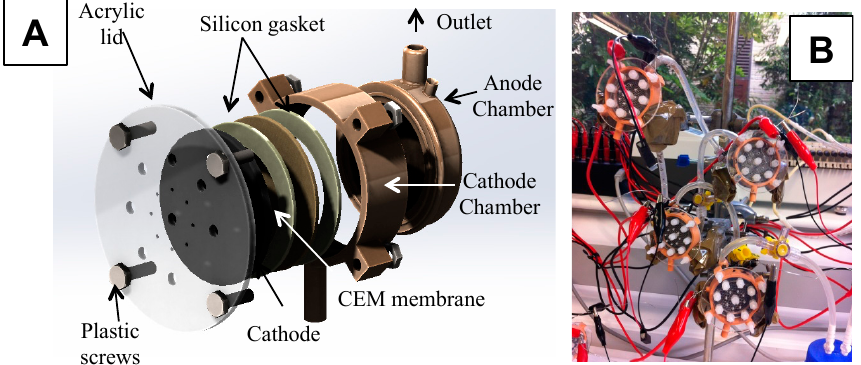
Figure 8. ( A ) 3D Computer ‐ Aided Design (CAD) MFCs design; and ( B ) a picture of the MFCs under